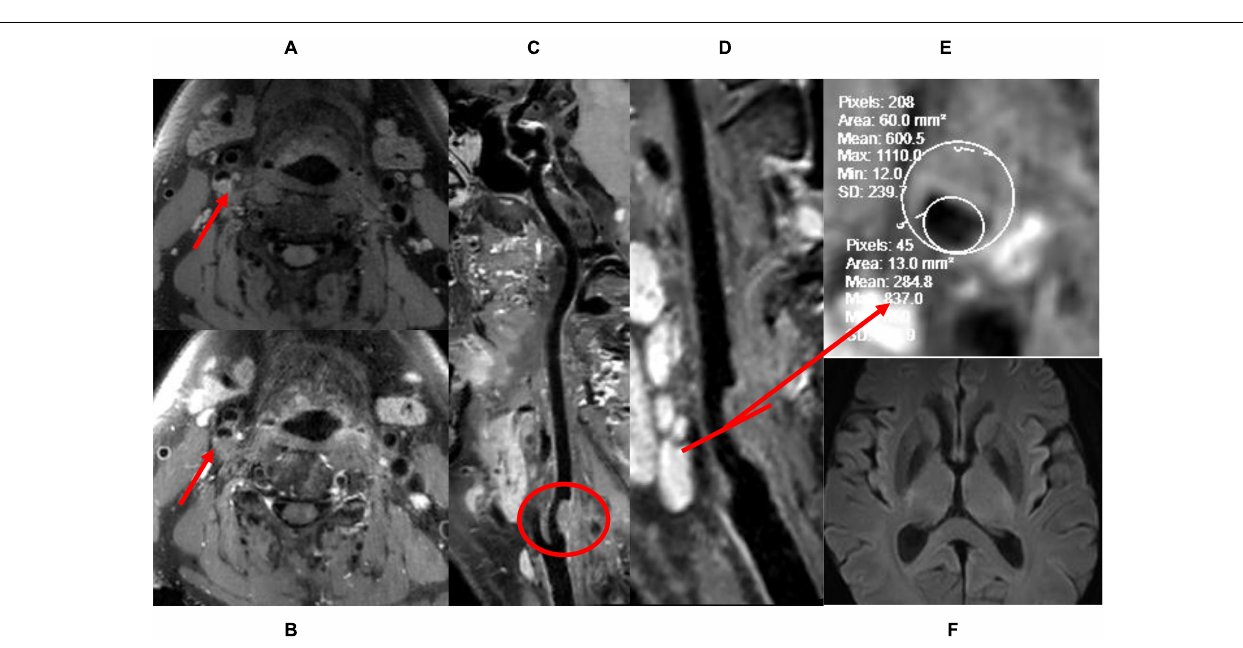
FIGURE 2 | The definition of low-risk plaque. (A) Pre-enhanced HRVW 3D T1 image. Intensity is homogeneous was seen in the plaque. (B) Post-enhanced HRVW 3D T1 image. No abnormal intensity was seen in the plaque. (C , D) Reconstruction map of post-enhanced HRVW 3D T1 image. Better display of the whole vessel and the plaque shown in red circle. (E) Section image, perpendicular to the lumen located in the plaque lesion. The stenosis rate can be determined in this section. (F) DWI. No abnormal hyperintensity was found in the whole brain, indicating no cerebrovascular events occurred.